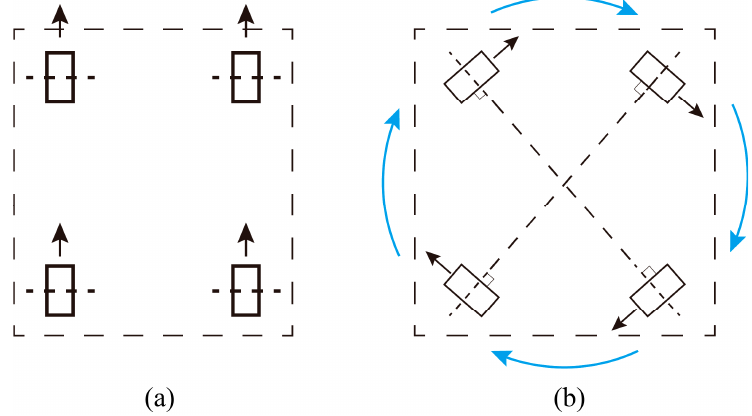
Figure 2. Structure examples for mobile and motion modes. ( a ) Moving forward. ( b ) Rotating in situ. The quantitative values of these two motions are defined by the forward moving distances and turning angles moving from one target point to the next. However, the movement’s actual quantitative value is not the same as the expected quantitative value because of the movement